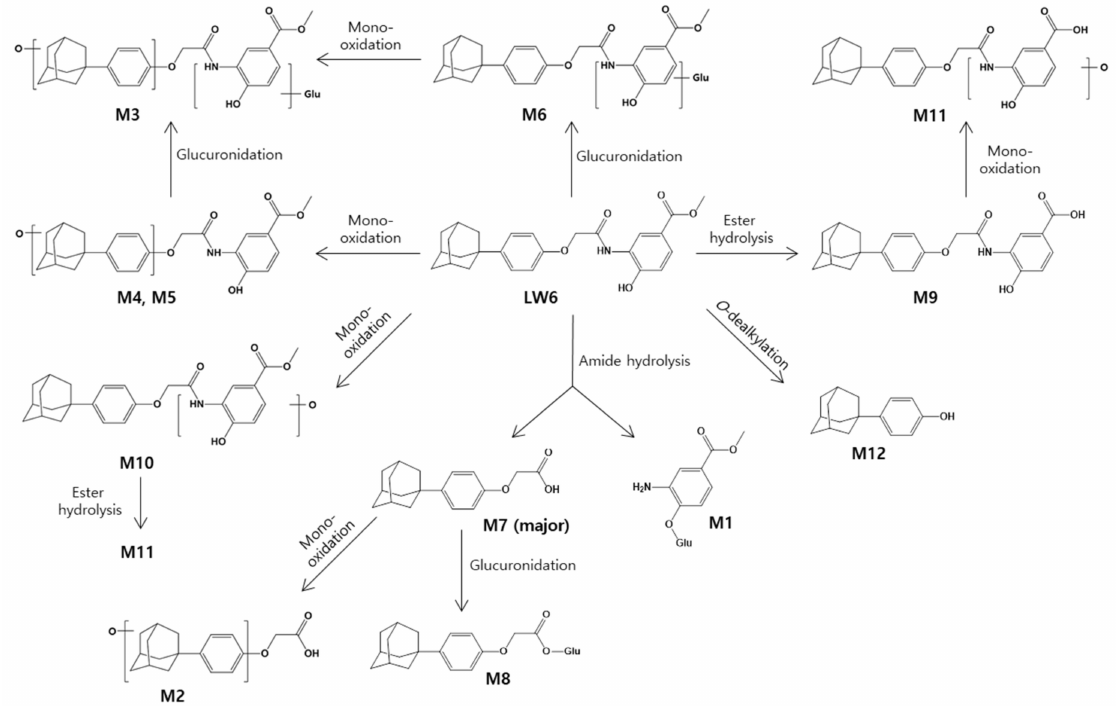
Figure 5. Proposed metabolic pathways of LW6 in